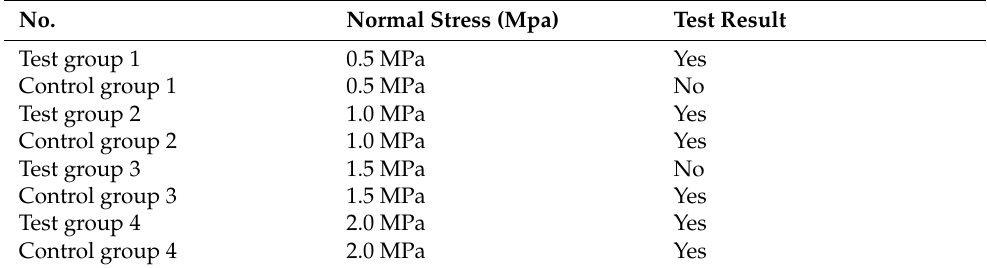
Figure 4. Shear experimental system. Table 1. Experimental